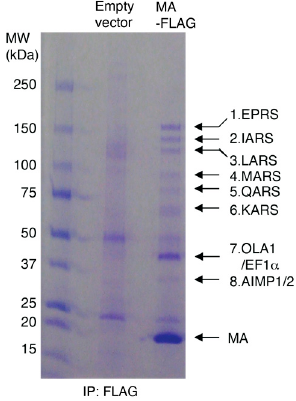
Figure 1. Co-purification of HIV-1 MA with MSC components. Lysates of HEK293 cells expressing MA-FLAG or empty vector control were subjected to FLAG immunoprecipitation. The precipitated protein was analyzed by SDS-PAGE and visualized by Coomassie blue staining. MSC components that co-immunoprecipitated with MA are indicated.